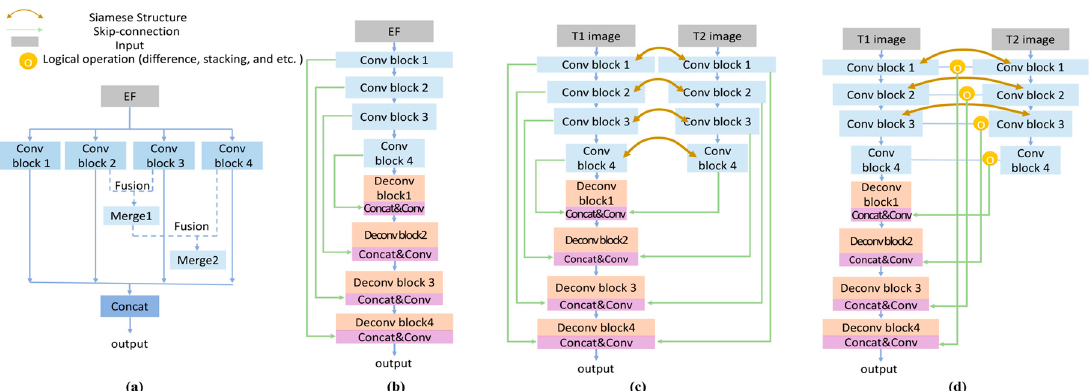
Figure 15. Schematic diagram of various feature fusion methods in CNN for enhancing data correlation. The first two structures are based on the EF fusion results, and the last two are based on the original image inputs. (a) Multi-hierarchical feature fusion structure based on the output of EF; (b) skip-connect structure based on the output of EF; (c) skip-connect structure of the dual-branch based on Siamese CNN; (d) operating skip-connect after feature logical operations based on Siamese CNN.